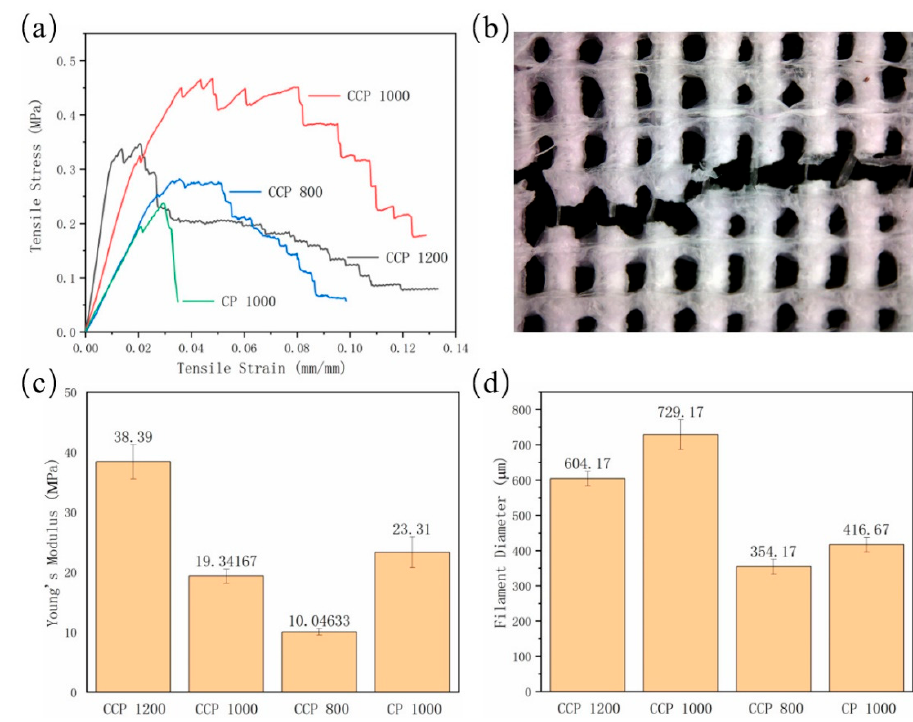
Figure 5. ( a ) The tensile stress/tensile strain curves of printed scaffolds; ( b ) the rupture of scaffold after tensile test; ( c ) the Young’s modulus of printed scaffolds; and ( d ) the filament diameter of printed scaffolds.